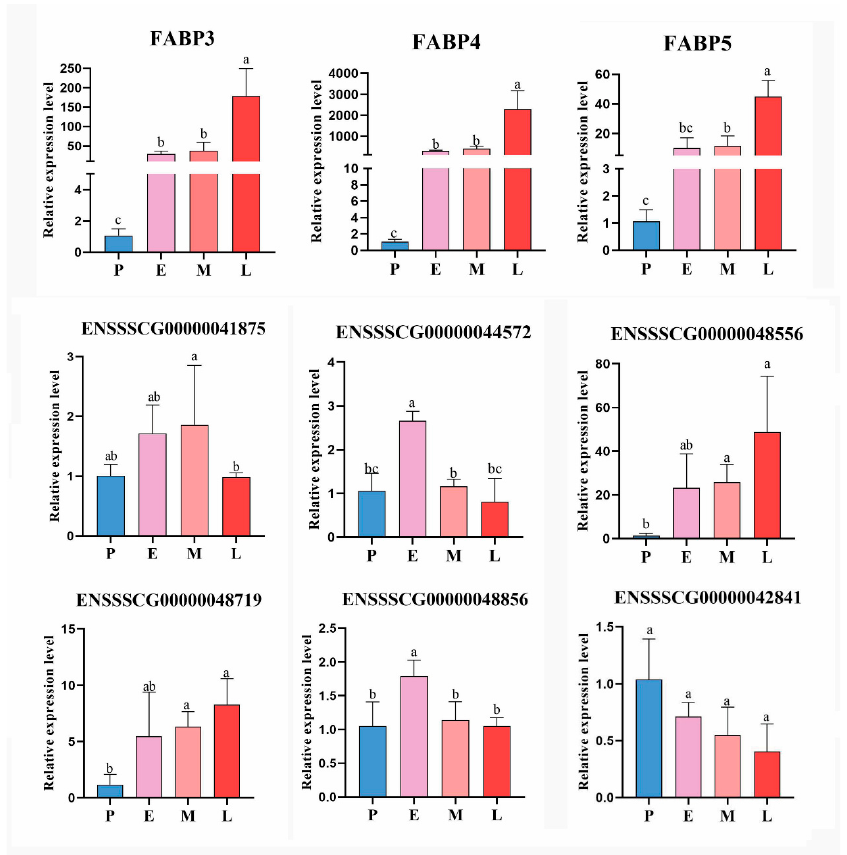
Figure 11. qPCR validation of the RNA-Seq expression results of three FABP genes and six DE lncRNAs. The data are presented as the means ± SEM. n = 3. Groups with the same letters have no difference with p > 0.05, and groups with different letters have difference with p < 0.05.